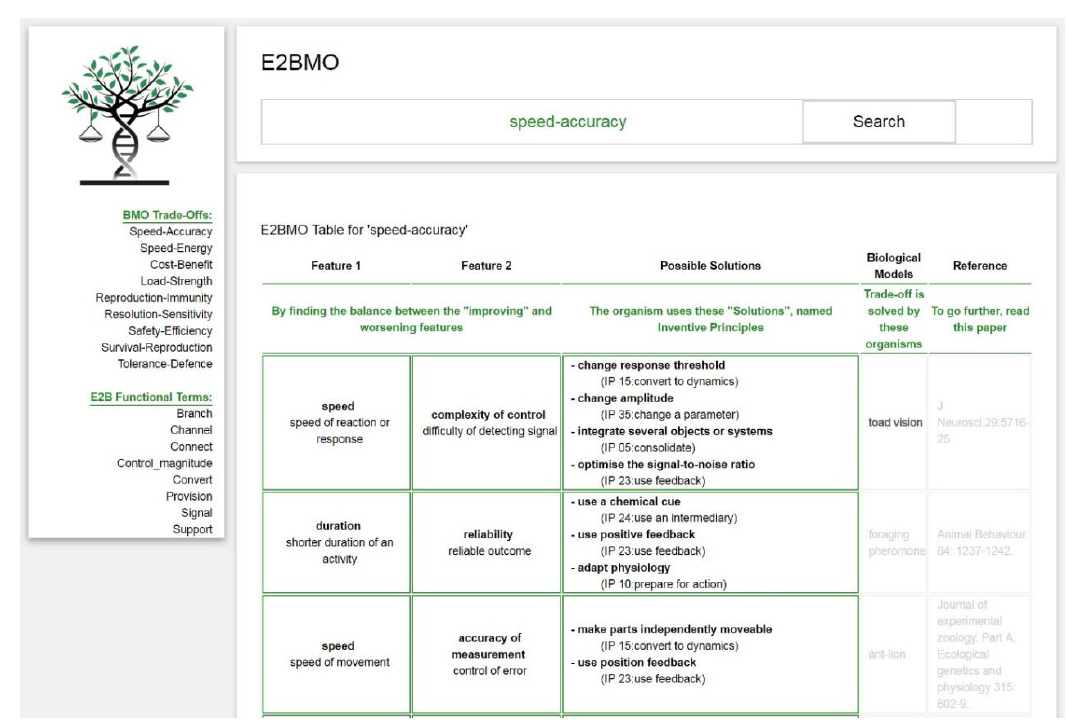
Figure 6. E2BMO query result for BMO Trade-Off Speed – Accuracy.